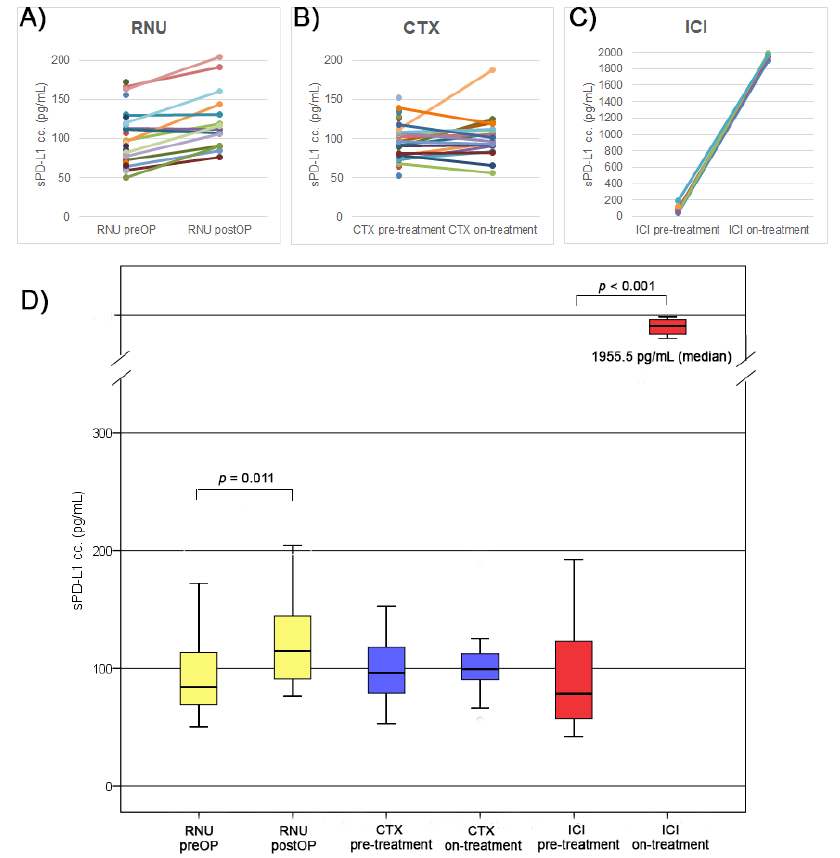
Figure 3. Box-plot presentation of sPD-L1 concentration changes in the RNU, CTX and ICI cohorts. ( A ) RNU cohort (preop. and postop. values), ( B ) CTX cohort (at chemotherapy baseline and on the first day of cycle 2), ( C ) ICI cohort (pretreatment and on-treatment values at 3 months), ( D ). We observed no differences in the pretreatment levels of sPD-L1 between the RNU vs. CTV, RNU vs. ICI and CTX vs. ICI cohorts ( p = 0.203, p = 0.391, p = 0.698, respectively). RNU — radical nephroureter- ectomy; CTX — chemotherapy; ICI — immune checkpoint inhibitor therapy. In the CTX cohort, the baseline median of sPD-L1 level was 96.1 pg/mL which re- mained unchanged (99.4 pg/mL, n = 18) after the first treatment cycle (Figure 3B,D).